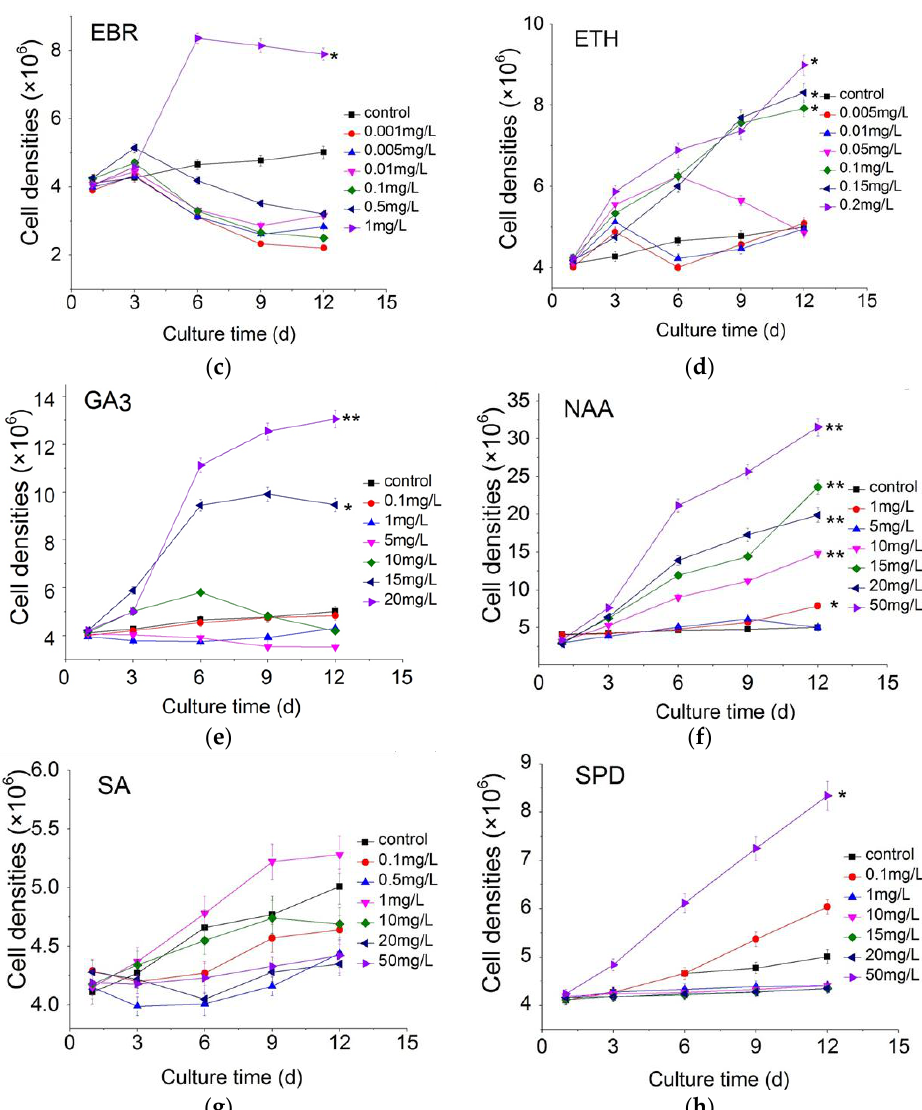
Figure 2. Growth rates of C. phyrenoidosa ZF strain with different concentrations of plant growth stimulants: ( a ) 6-BA treatments; ( b ) ABA treatments; ( c ) EBR treatments; ( d ) ETH treatments; ( e ) GA 3 treatments; ( f ) NAA treatments; ( g ) SA treatments; ( h ) SPD treatments.